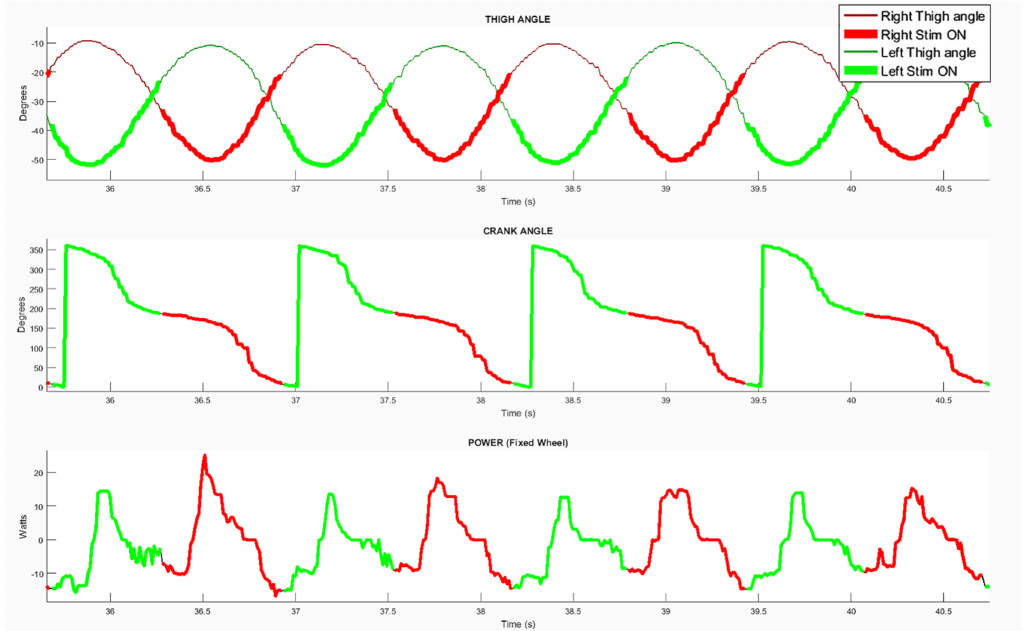
Figure 5. Data sample illustrating the results over four pedaling cycles in home trainer conditions. ( Top ) Left (green) and right (red) thigh tilting angles; ( middle ) crank angle; ( bottom ) developed power. The two stimulation channels activation are